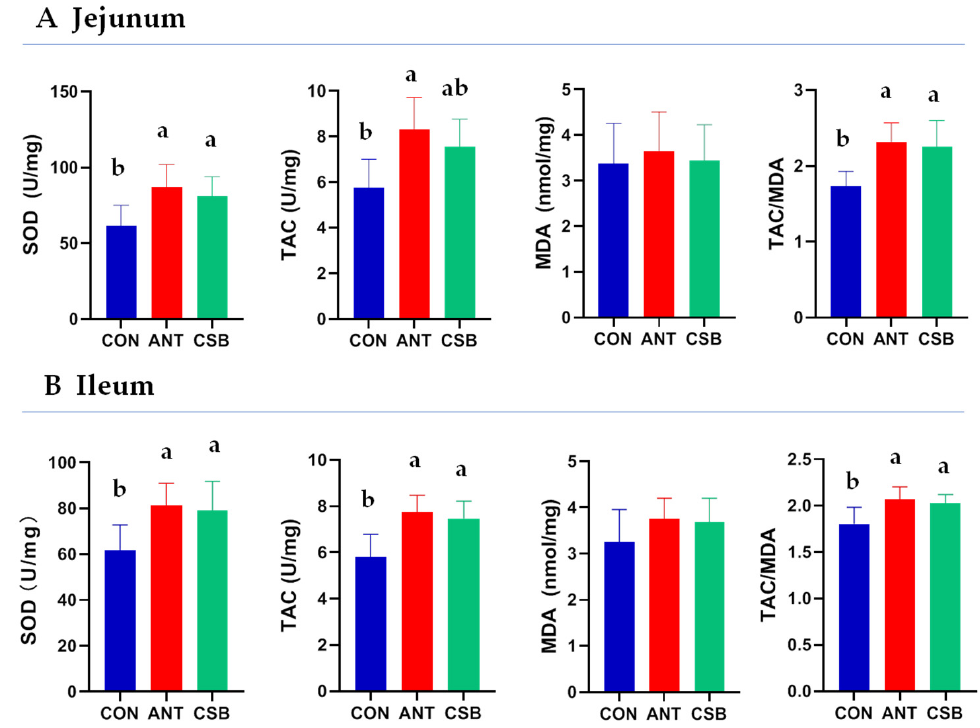
Figure 3. Effects of CSB on mucosal antioxidant capacity of the jejunum and ileum in broilers at 21 d of age. SOD: superoxide dismutase, U/mg prot.; TAC: total antioxidant capacity, U/mg prot.; MDA: malondialdehyde, nmol/mg prot.; TAC/MDA: the ratio of TAC to MDA. a,b: means that there was significant difference in the bars labeled with different letters ( p <